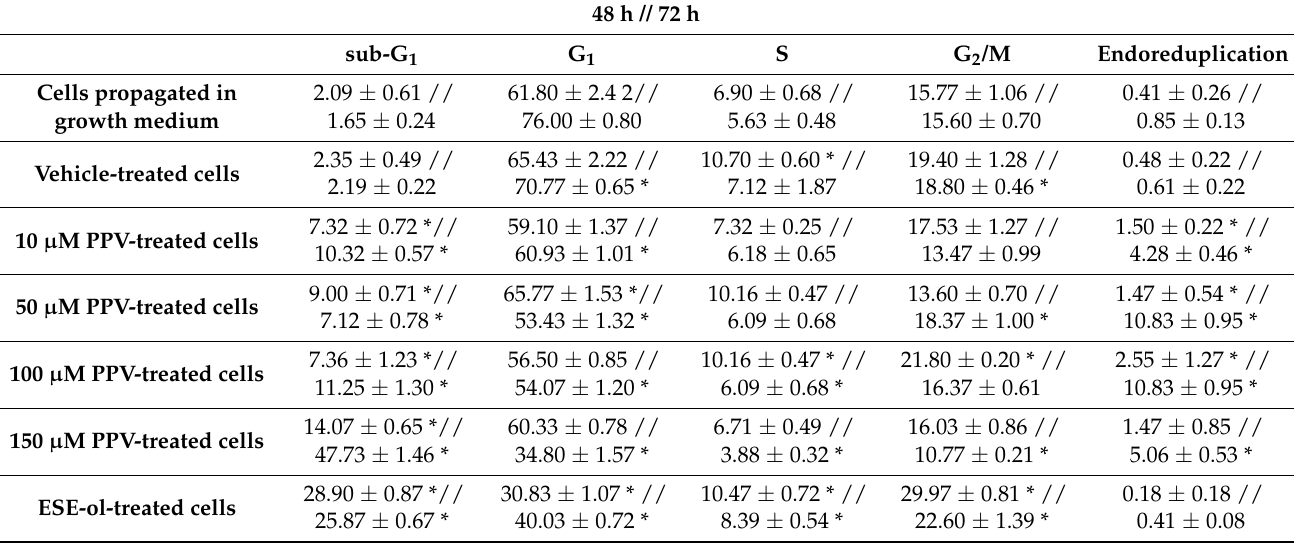
Table 1. The effects of PPV on cell cycle and cell death induction as a percentage of cells in each phase of the cell cycle on MDA-MB-231 cells at 48 h // 72 h. Statistical significance is represented by an * when using the Student t -test with a p value of 0.05 compared to cells propagated in growth